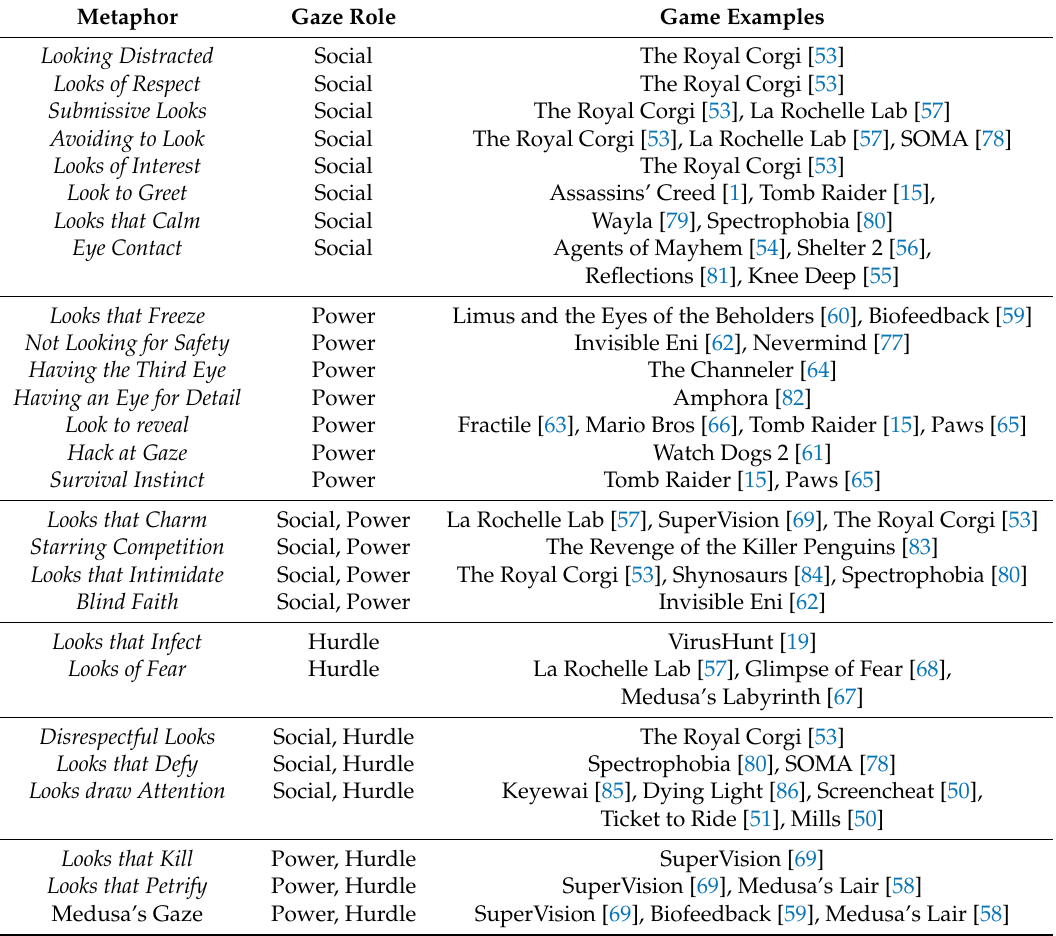
Table 1. List of Surveyed Gaze Metaphors related to each gaze